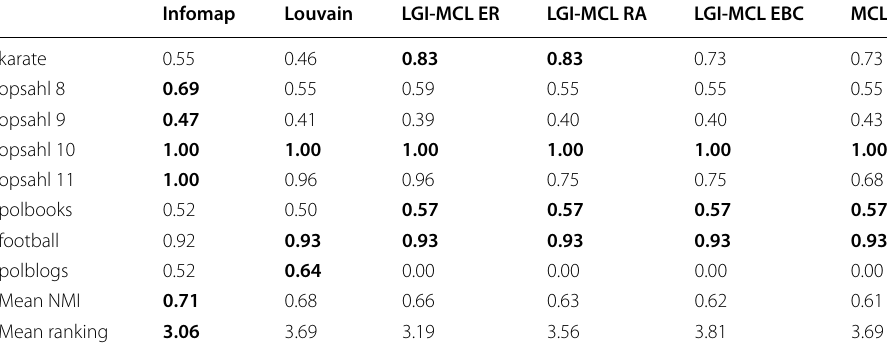
Table 2 Community detection on real networks